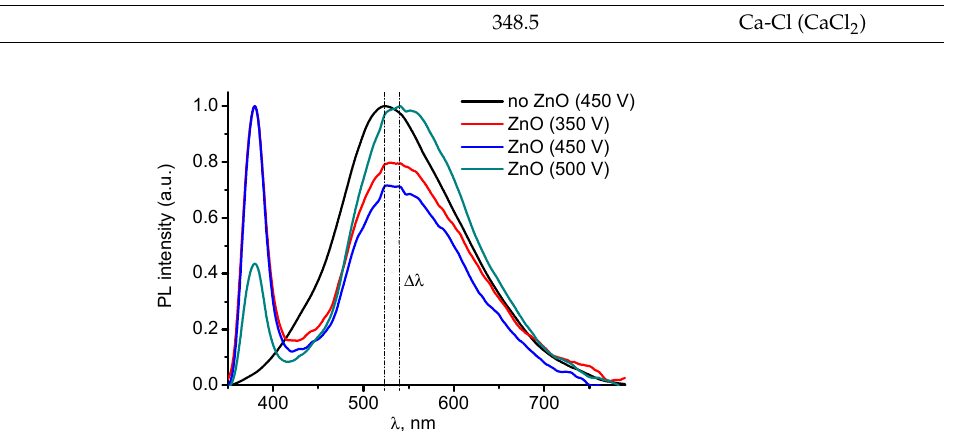
Figure 6. The high resolution XPS spectra after the deconvolution procedure, sample TiZr-350-ZnO.